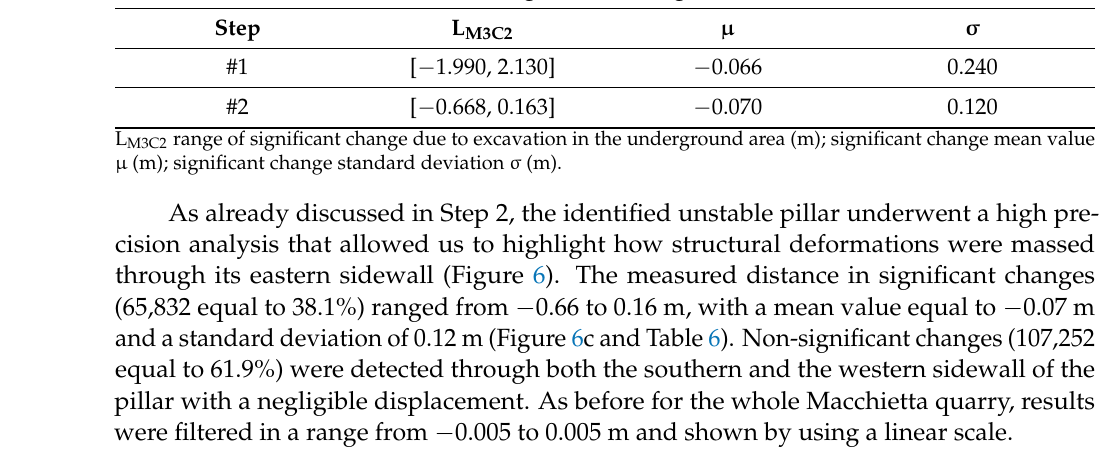
Table 6. Results from the change detection analysis.